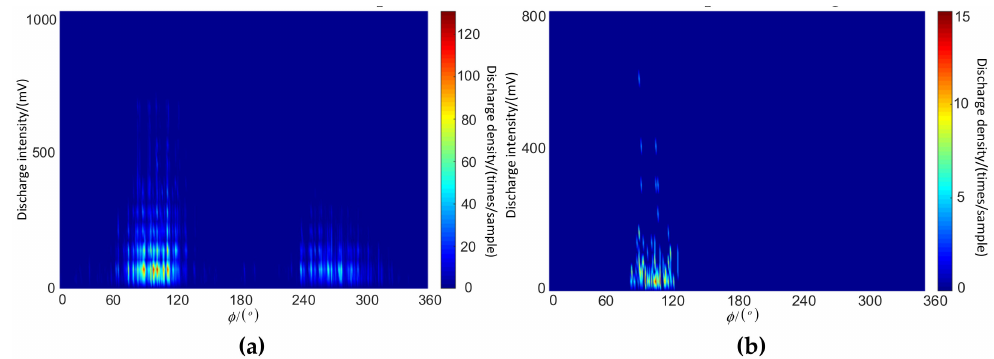
Figure 4. Phase-resolved partial discharge (PRPD) patterns of the needle defect under 20 kV. ( a ) A PRPD pattern of the optical detection and ( b ) a PRPD pattern of the UHF detection.